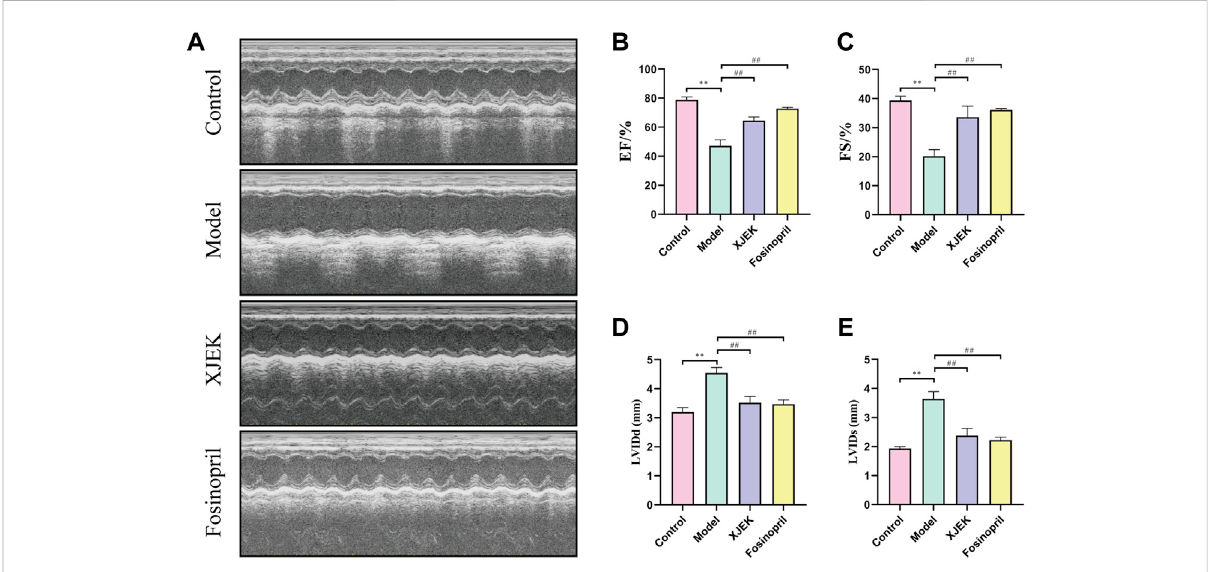
FIGURE 1 MIR-induced cardiac dysfunctions were reverted by XJEK. (A) Representative images of echocardiography with M-mode. Quantitative data of LVEF (B) , LVFS (C) , LVIDd (D) and LVIDs (E) from mice were presented here. pp p < 0.01 versus control group; ## p < 0.01 versus MIR model group. Data were expressed as mean ± SD ( n = 6 mice for each